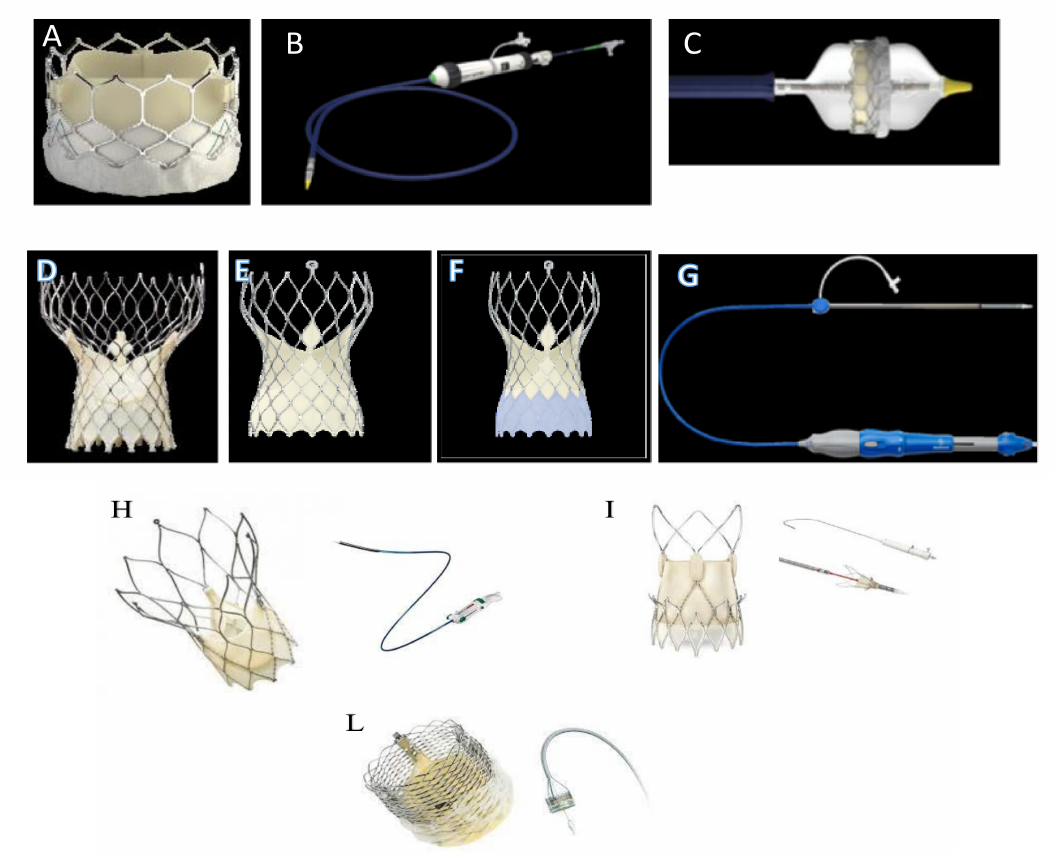
Figure 6. Balloon-expandable THV. ( A – C ) The SAPIEN 3 balloon-expandable device is constituted by a cobalt–chromium alloy frame valve with bovine pericardium leaflets. The device is available on the market in the following sizes: 20 mm, 23 mm, 26 mm, and 29 mm ( A ). The Commander Delivery System is 14 F expandable introducer sheath compatible with 20–26 mm valves and 16 F expandable introducer sheath compatible with 29 mm valves ( B , C ). ( D – G ) Self-expandable THV. The bioprosthesis is manufactured by suturing 3 valve leaflets and a skirt, made from a single layer of the porcine pericardium, onto a self-expanding, multi-level, radiopaque frame made of Nitinol ( D – F ). CoreValve ( D ), Evolut R ( E ), and Evolut PRO ( F ) in the following sizes: 20 mm, 23 mm, 26 mm, and 29 mm. ©. The loading system. The outer diameter of the catheter is 15 Fr (AccuTrak™ stability layer) and 12 Fr, and the outer diameter of the valve capsule is 18 Fr. The catheter can be used for femoral, subclavian/axillary, or ascending aortic (direct aortic) access sites. ( H ) The Portico